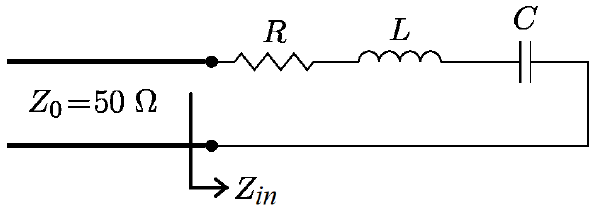
Figure 1. Model of a serial RLC resonator excited by a transmission